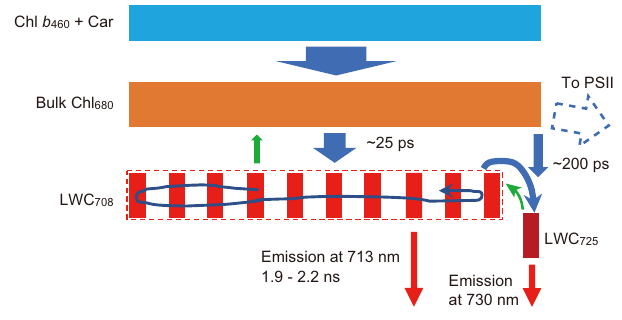
Fig. 9 | Kinetic model of the EET in Pc-frLHC. The blue box shows the Chl b and carotenoid (Car) poolthatisdirectly excitedby the460nm laser. The orange, red, and dark-red boxes are the Chl pools of 680nm ‒ emitting bulk Chl, the 713nm ‒ emitting LWC 708 pool, and the 730nm ‒ emitting LWC 725 pool, respectively. The widths of the boxes roughly express the number of pigments contained in the pools.Theblueandgreenarrowsindicatethedownhillanduphillenergytransfers, respectively. The rate of the uphill energy transfer is temperature dependent. The winding blue arrowshowstheenergymigrationsbetweentheisoenergeticLWC 708 pigments. Red arrows indicate deexcitation by the fl uorescence emission, dis- sipation to heat, etc. The blue dotted open arrow shows a possible energy exit for PSII. Approximate time constants are given beside the